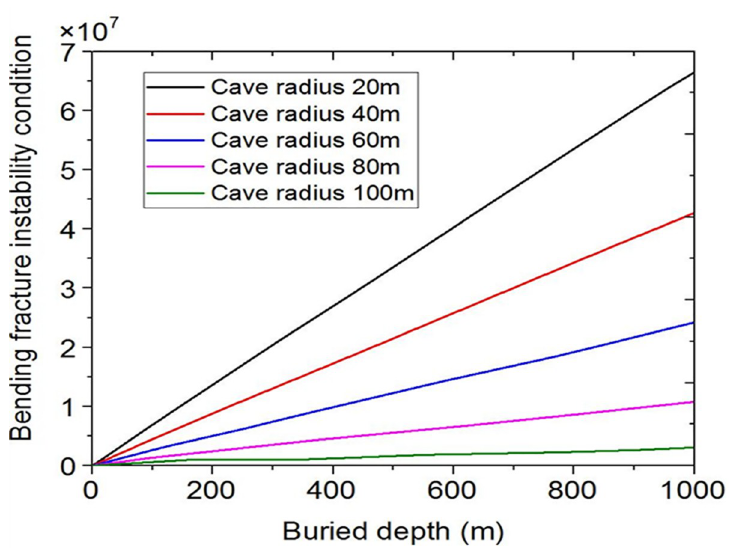
Fig 7. Influence curves of different cave radius.